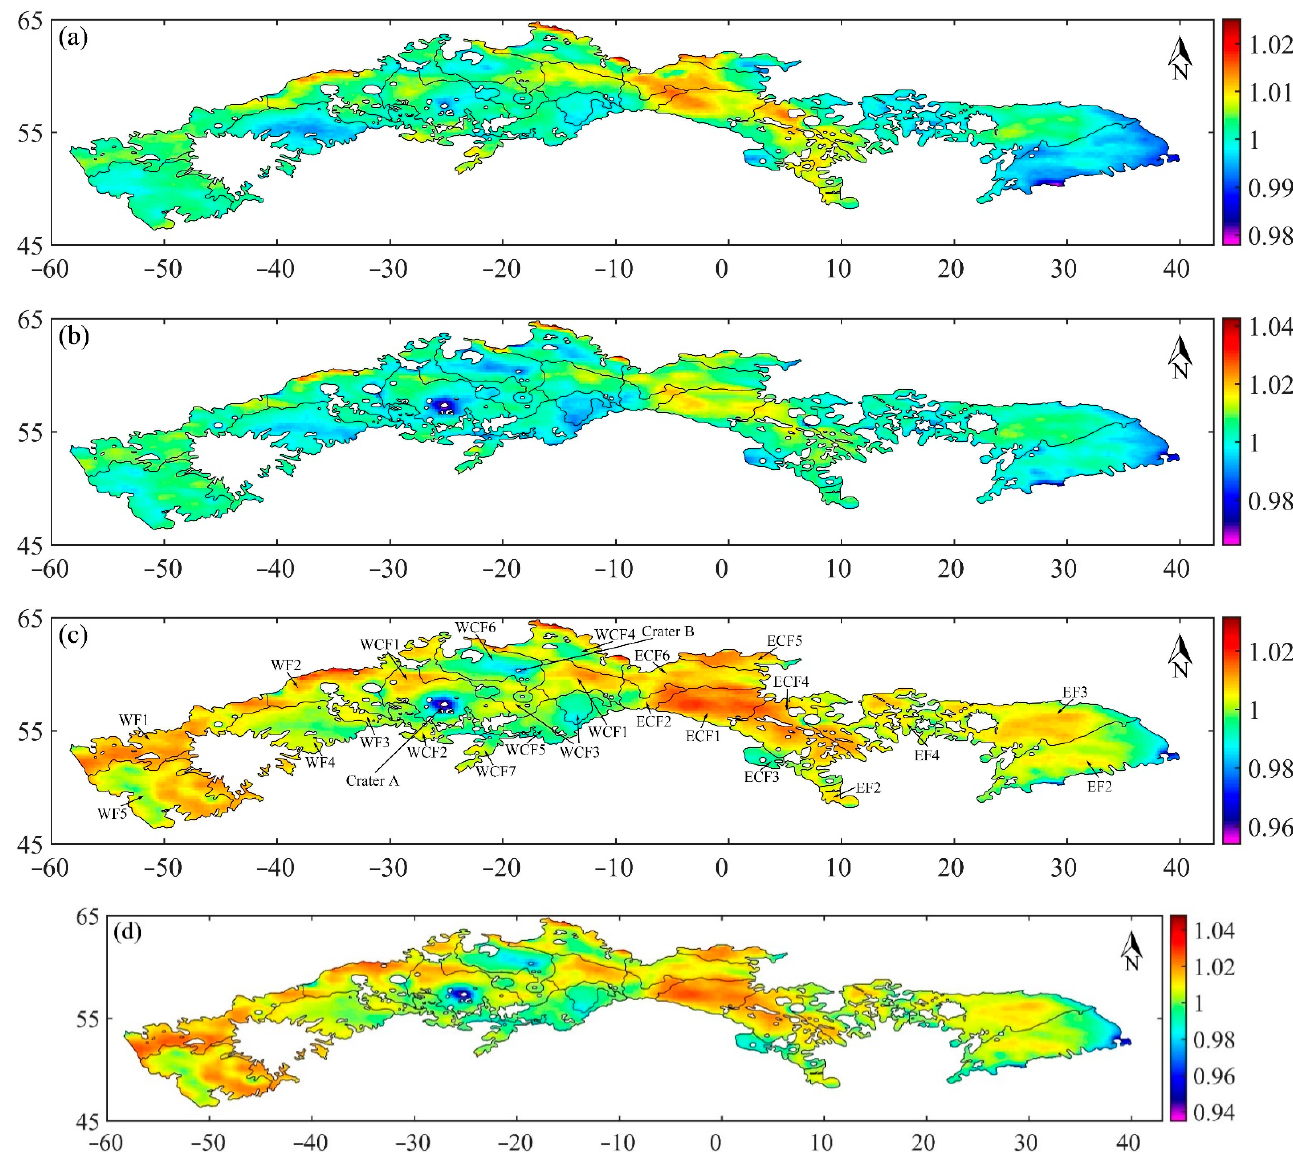
Figure 4. Normalized TB maps of Mare Frigoris at noon: ( a ) 3.0 GHz, ( b ) 7.8 GHz, ( c ) 19.35 GHz, and ( d ) 37 GHz (equidistant cylindrical projection). The black lines are the geologic boundaries of Mare Frigoris mapped by Kramer et al. [2]. Crater A and Crater B are two craters with TB anomalies, as discussed in Sections 3.2.2 and 4.2.1.